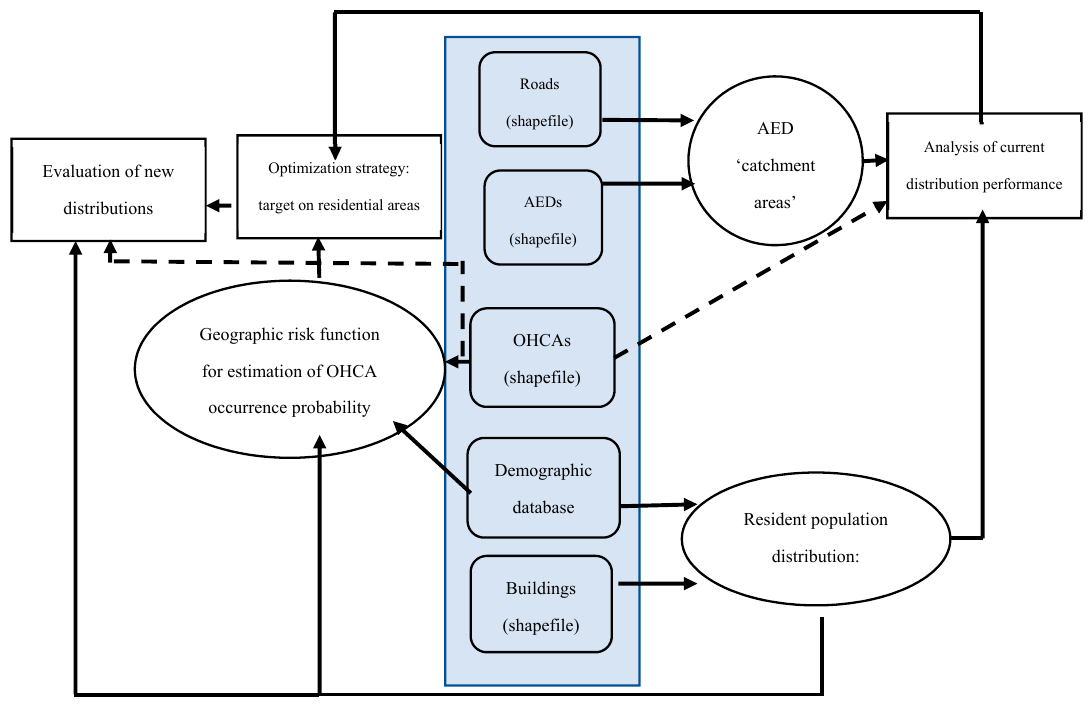
Figure 2. Schematic representation of the proposed framework, with data sources highlighted in the gray box. See text for further